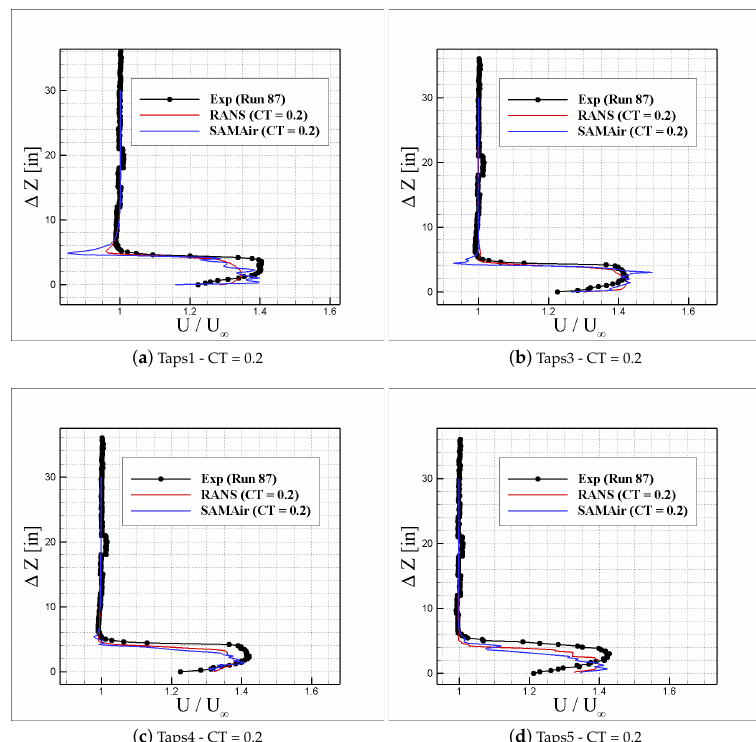
Figure 17. Wake survey validation of x-velocity for wing propeller at CT = 0.2 and α = 0 ◦ .